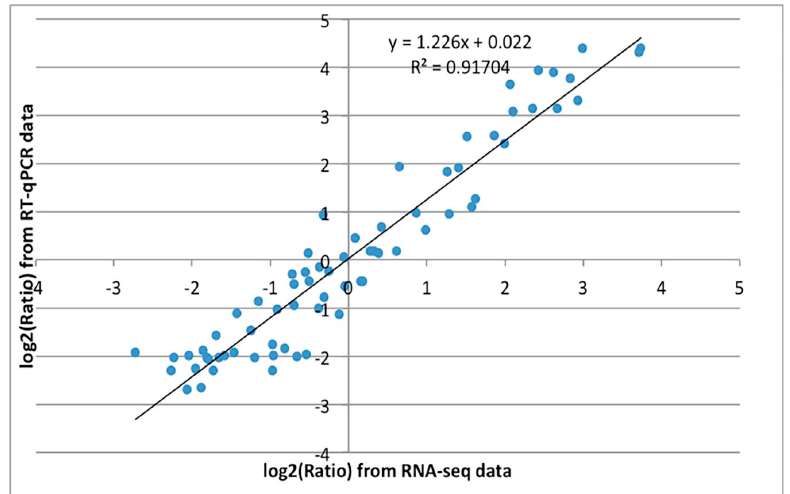
Figure 8. Coefficient analysis of fold change data between qRT-PCR and RNA-seq. 14 unigenes were selected for qRT-PCR. Data indicating the relative transcript level from qRT-PCR are the means of three replicates. Scatterplots were generated by the log2 expression ratios from RNA-seq ( x -axis) and RT-qPCR ( y -axis).